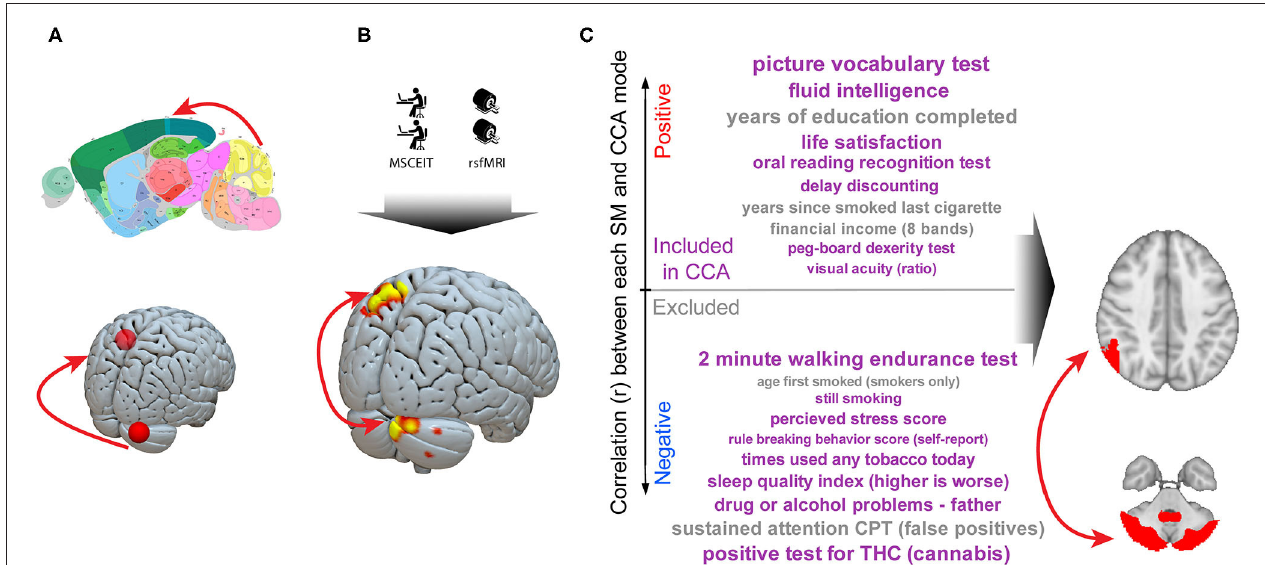
FIGURE 3 | A cerebellar–parietal circuit is causally linked to social cognition both trans-diagnostically and trans-species. A series of murine and human experiments converge on a shared circuit causally linked to social cognition. (A) Imaging studies reliably identify cerebellar right Crus abnormalities in autism. Neuromodulation experiments in humans identify a circuit linking right Crus to the left parietal lobe and murine studies demonstrate this circuit is critical to normal social interaction ( 48). (B) We observe that, in a trans-diagnostic sample, connectivity between right cerebellar Crus and left parietal lobe connectivity is directly linked to social cognitive ability. (C) In a large ( n = 461) dataset, connectivity in this cerebellar Crus–parietal circuit was the strongest link between a broad array of outcomes along a “positive–negative axis” (71). Taken together, these data are consistent with a critical role for a cerebellar–cortical circuit in complex social cognition. Murine image from the Allen Mouse Brain